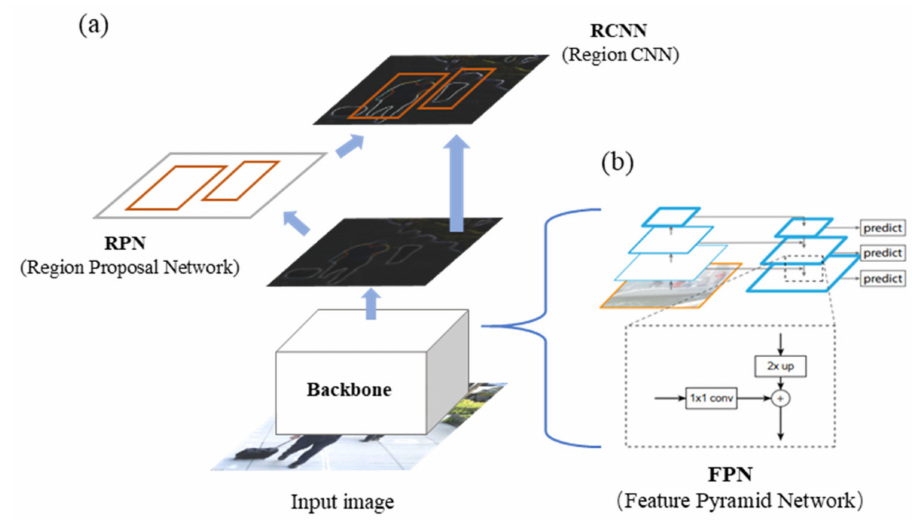
Figure 10. The architecture of Faster RCNN with FPN backbone, ( a ) The framework of Faster RCNN; ( b ) The framework of FPN.